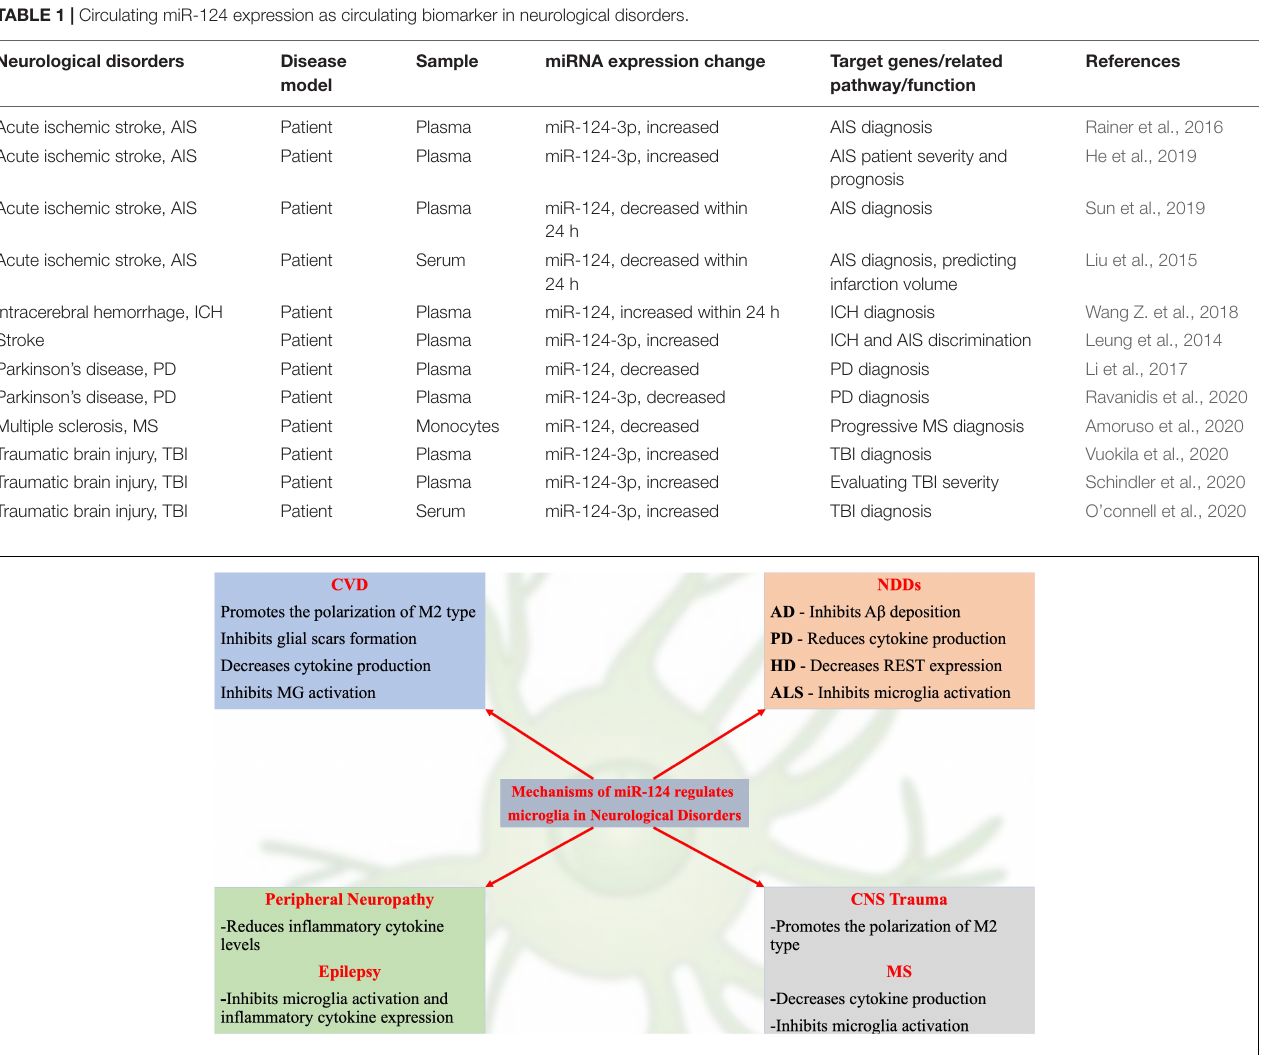
FIGURE 1 | Schematic representation of current hot topics and emerging mechanisms of miR-124 in regulating microglia in neurological disorders.